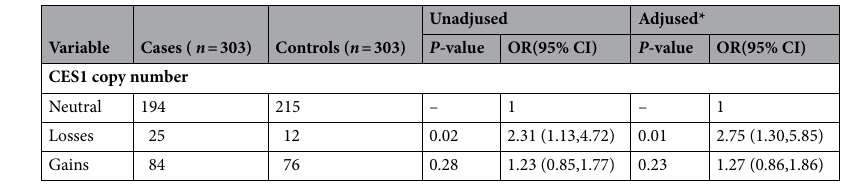
Table 2. Association of CES1 copy numbers with NAFLD. CES1, carboxylesterase 1; NAFLD; non-alcoholic fatty liver disease. *Adjusted for age, sex, educational level, occupational status, income, marital status, smoking status, tea drinking status, exercise, history of diabetes, hyperlipidaemia, and